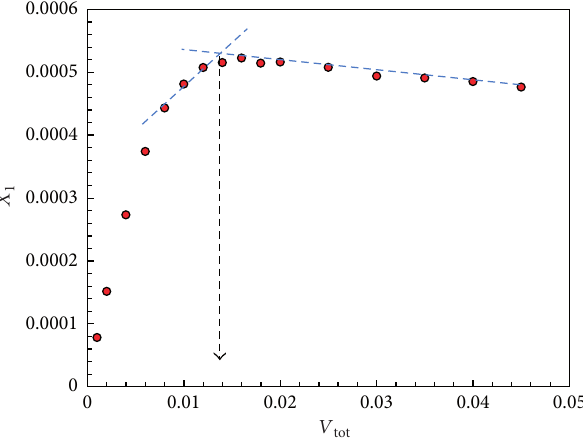
as a double chain surfactant. From this graph CMC is estimated nearly 0.02. e slope of the graph increases aer